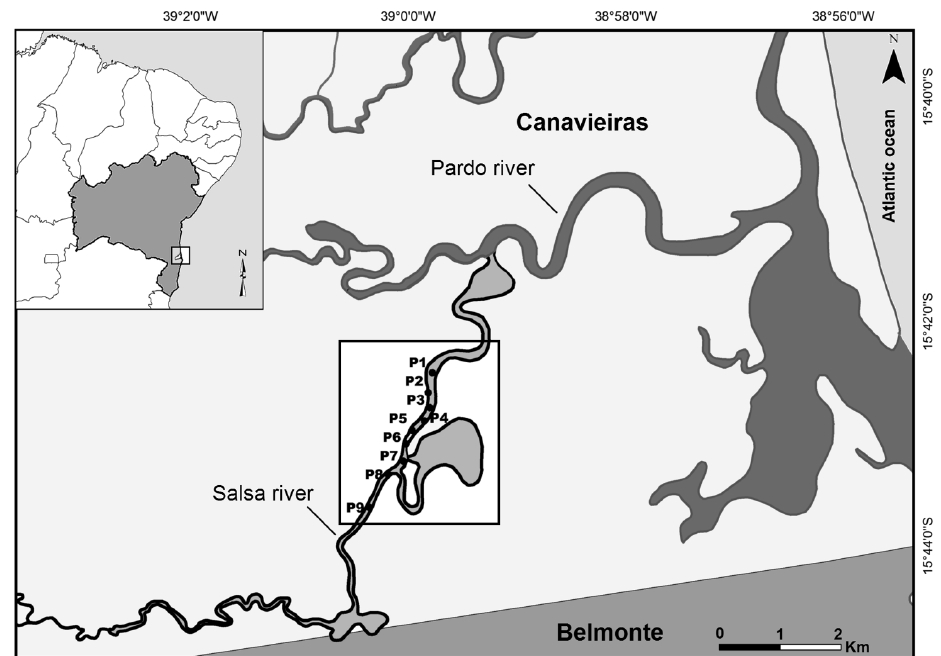
Figure 1. Location of sampling sites in the study